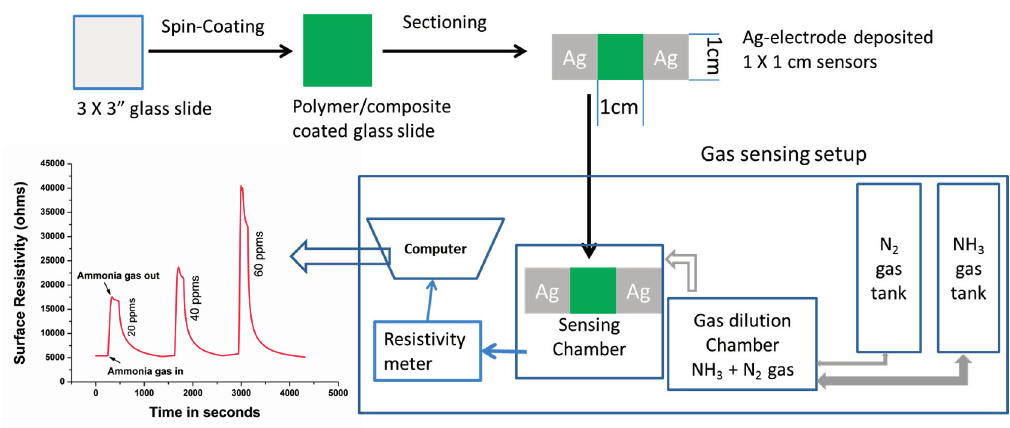
Figure 7. Complete flow chart of the gas sensing process, which includes the sensor fabrication and sensitivity measurement process along with a representative raw